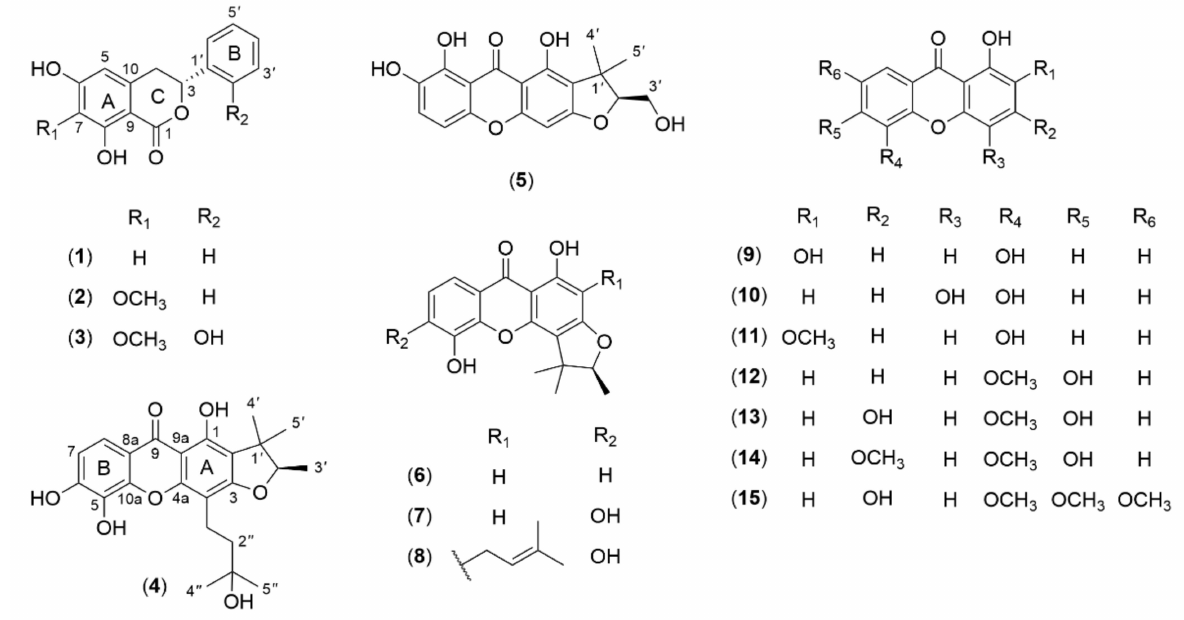
Figure 1. Isolated compounds ( 1 - 15 ) from the stem bark of Garcinia picrorhiza . Compound 3 was obtained as a pale yellow amorphous solid with a molecular formula of C 16 H 14 O 6 based on its molecular ion peak at m / z 325.0693 [M + Na] + in